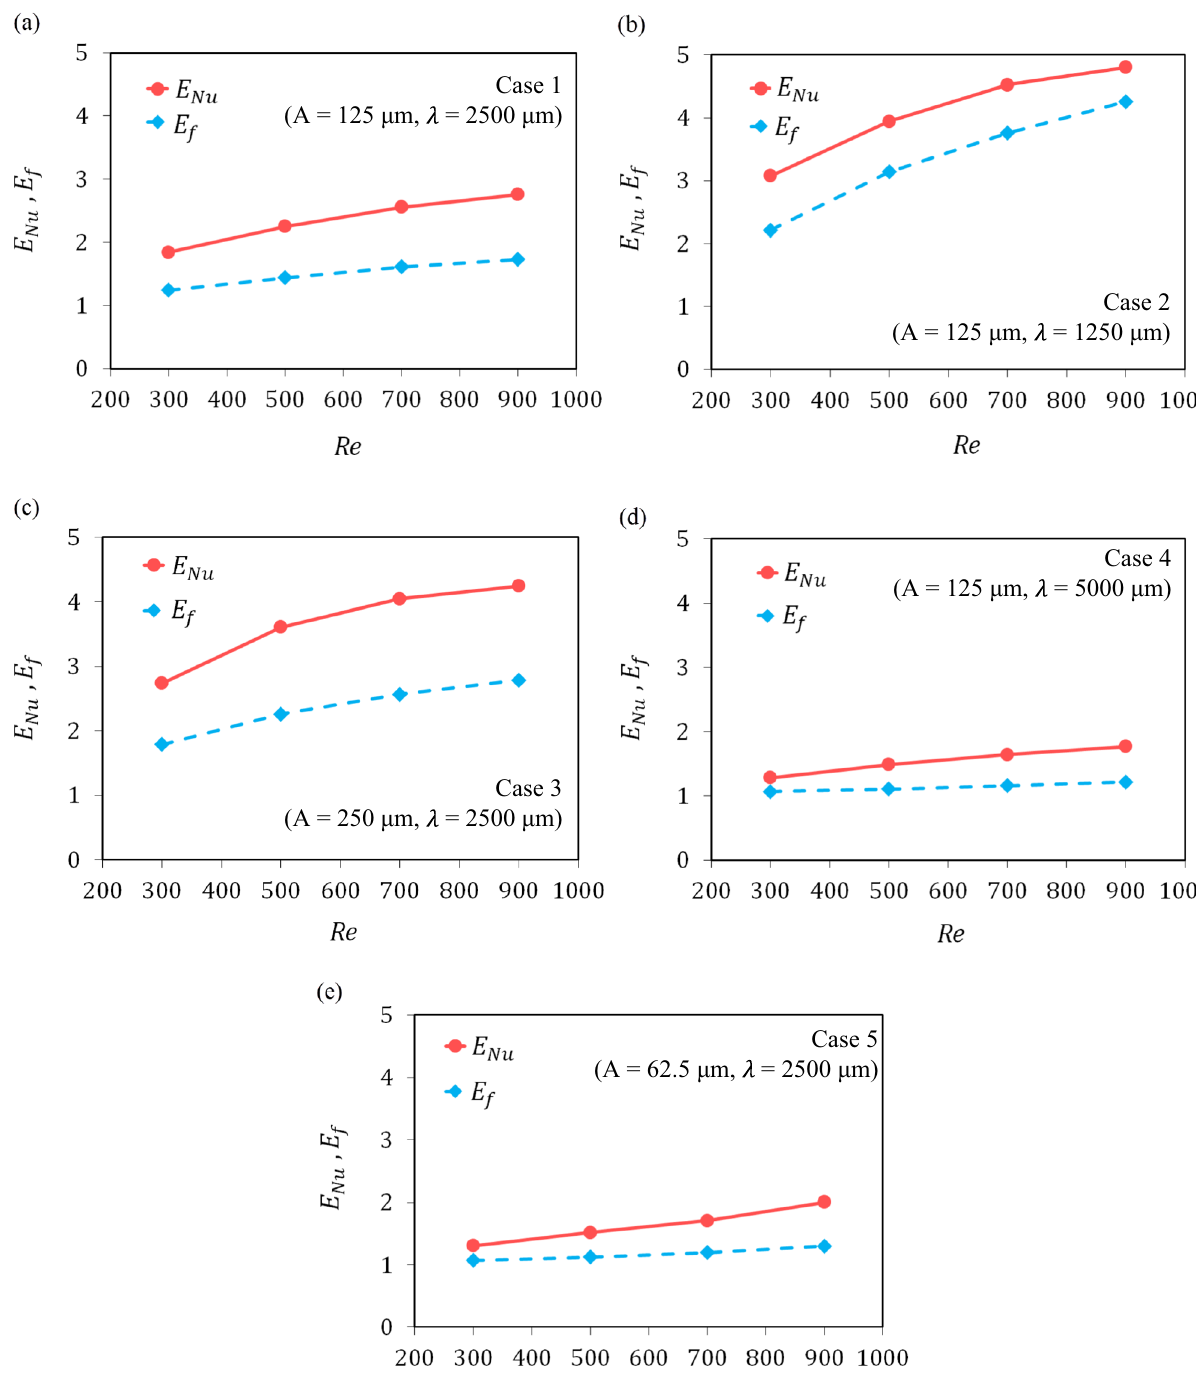
Figure 10. The Nusselt number enhancement and the friction factor enhancement for: ( a ) Case 1 (A = 125 μm, λ = 2500 μm), ( b ) Case 2 (A = 125 μm, λ = 1250 μm), ( c ) Case 3 (A = 250 μm, λ = 2500 μm), ( d ) Case 4 (A = 125 μm, λ = 5000 μm), and ( e ) Case 5 (A = 62.5 μm, λ = 2500